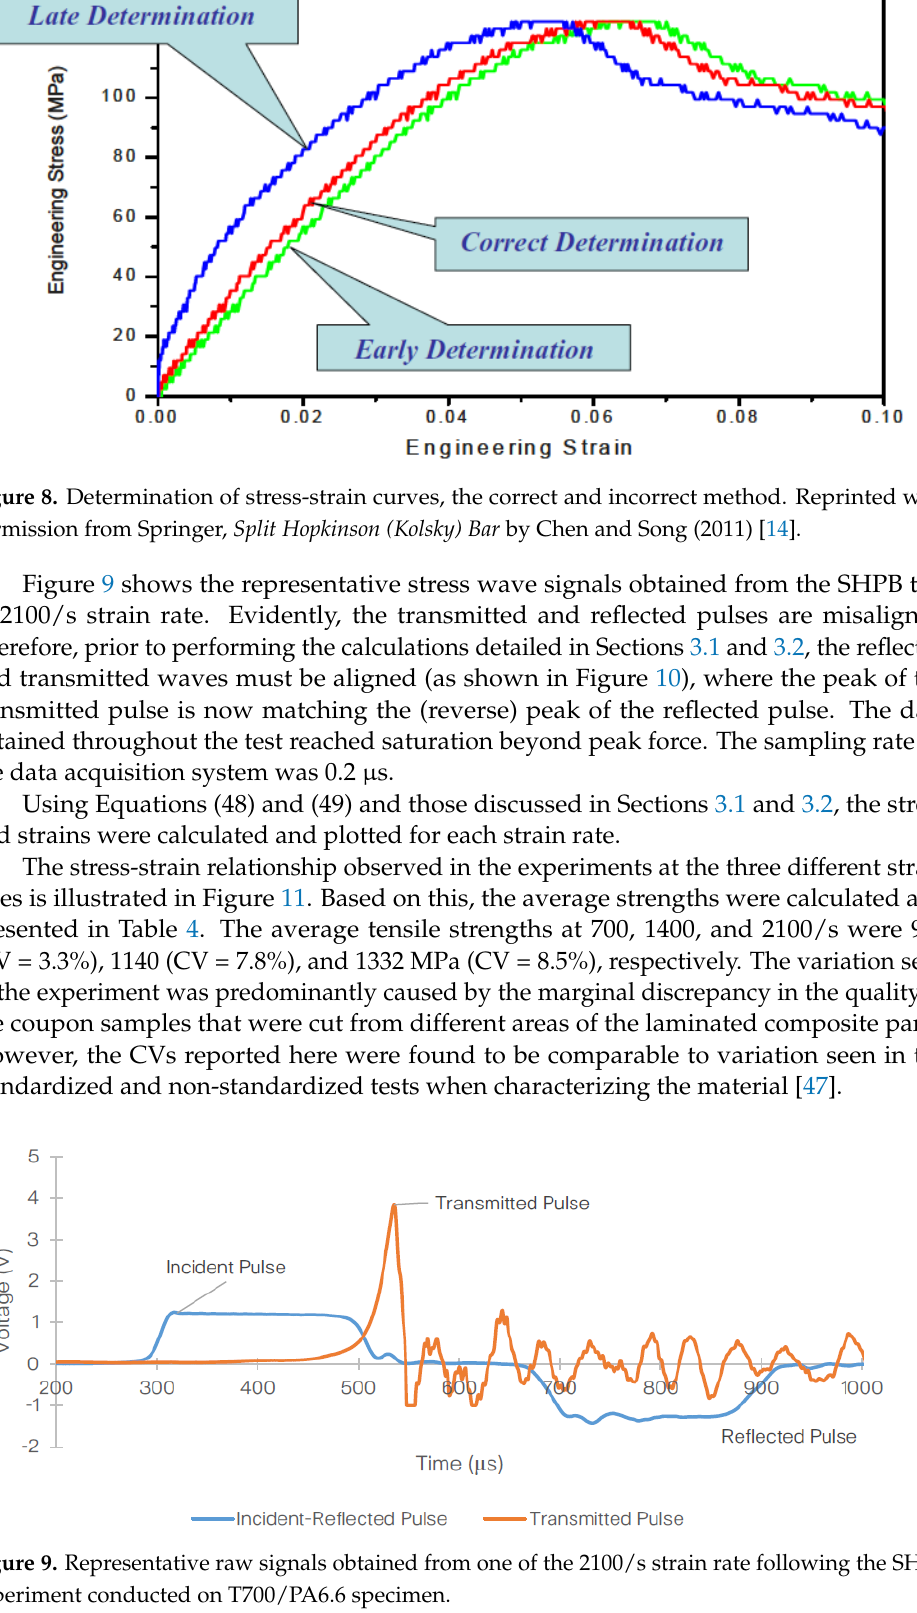
Figure 7. Determining the stress equilibrium, the correct and incorrect method. Reprinted with